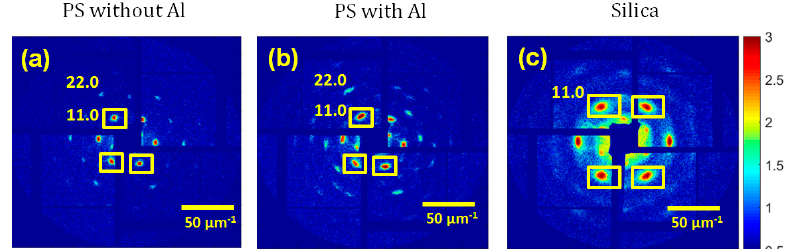
Figure 4. Single-shot diffraction patterns (in logarithmic scale) from colloidal crystals made from ( a ) PS, ( b ) PS covered with Al layer, and ( c ) silica samples measured at LCLS. Squares indicate Bragg peaks considered in the further analysis.